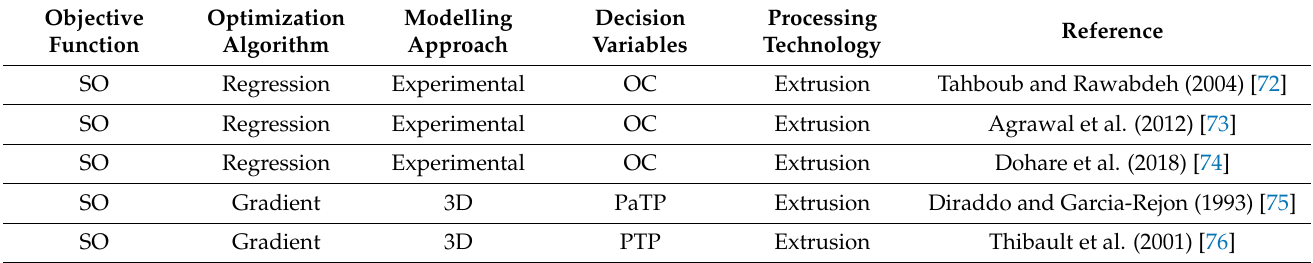
Previous publications on the optimization of blow molding. Decision